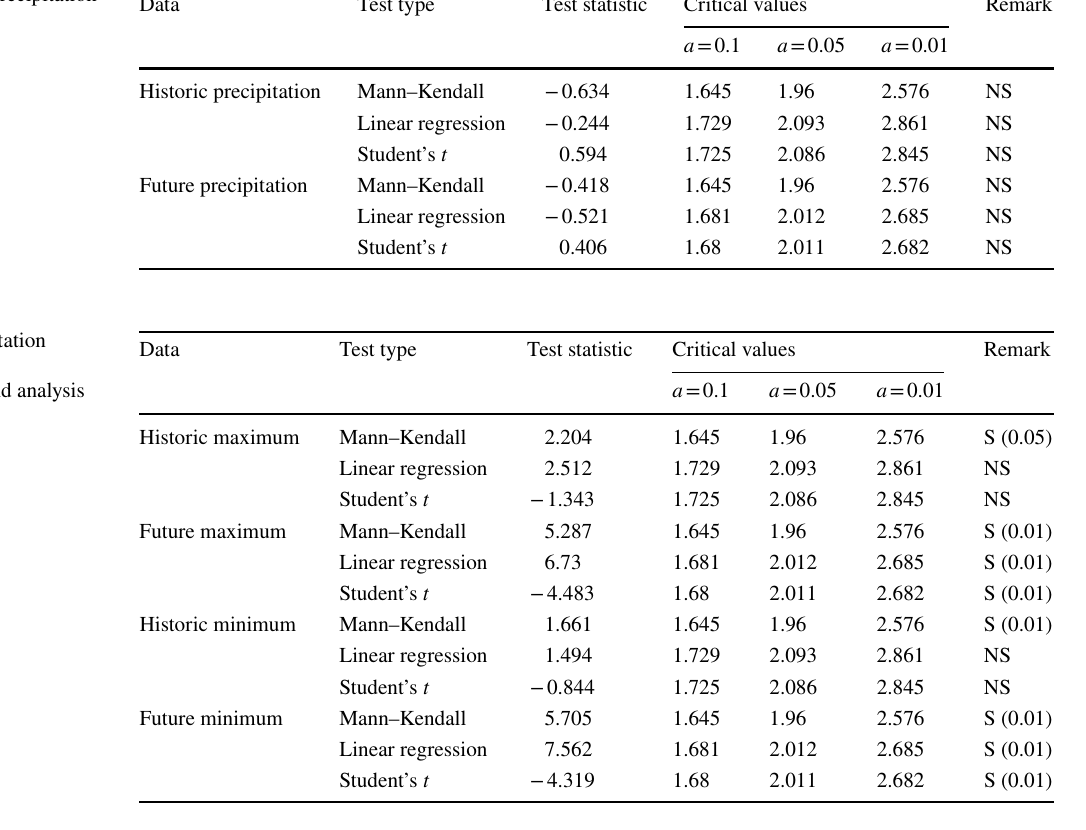
Table 2 Gp113221 precipitation